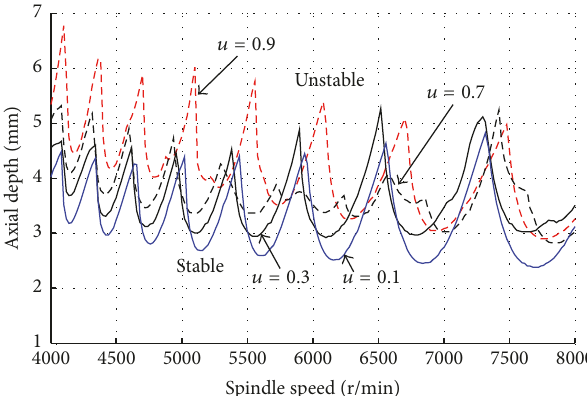
Figure6:Stabilitylimitdiagramwhenthetoolcuttingtoolposition. 22.533.544.55